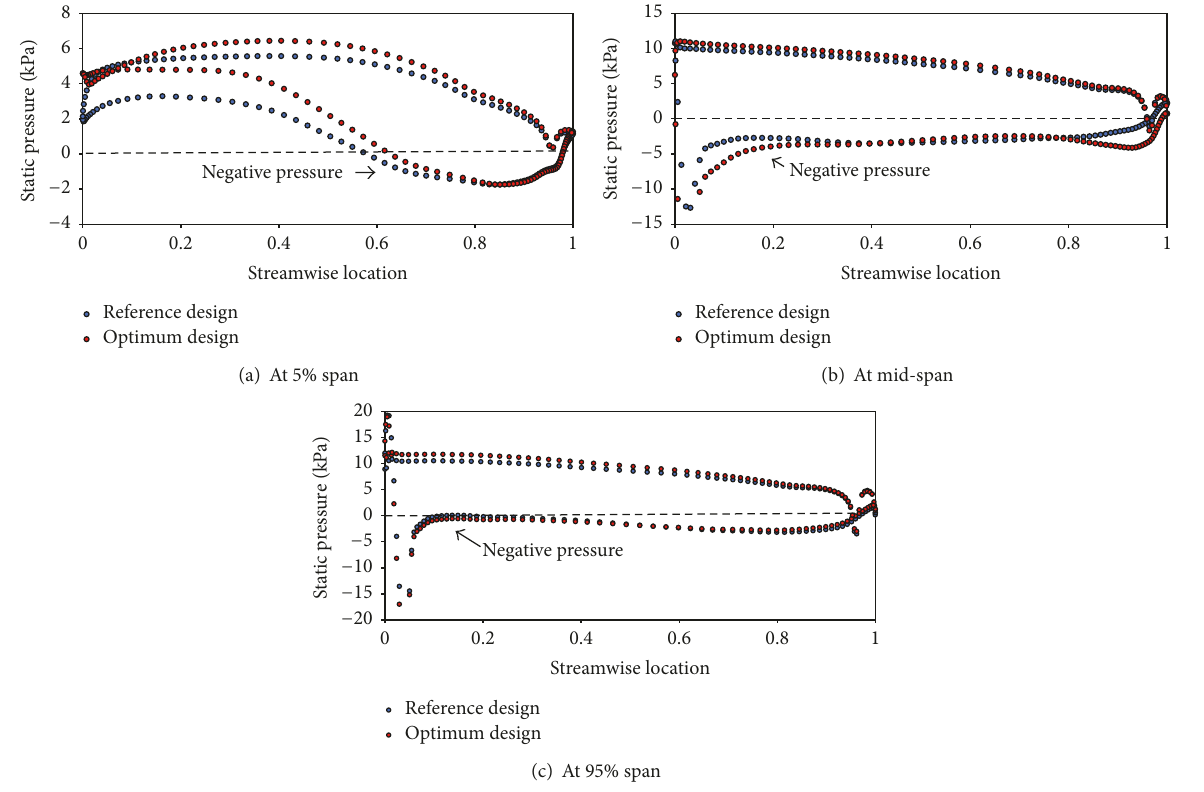
Figure 13: Static-pressure distributions on the blade surfaces of the rear